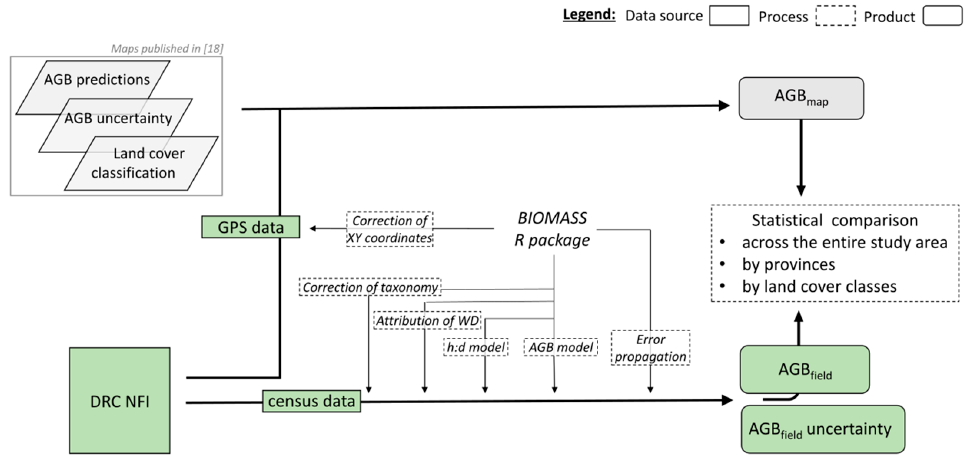
Figure 2. Methodological workflow of the analysis. AGB predictions, AGB uncertainty and Land cover maps were published in [18].